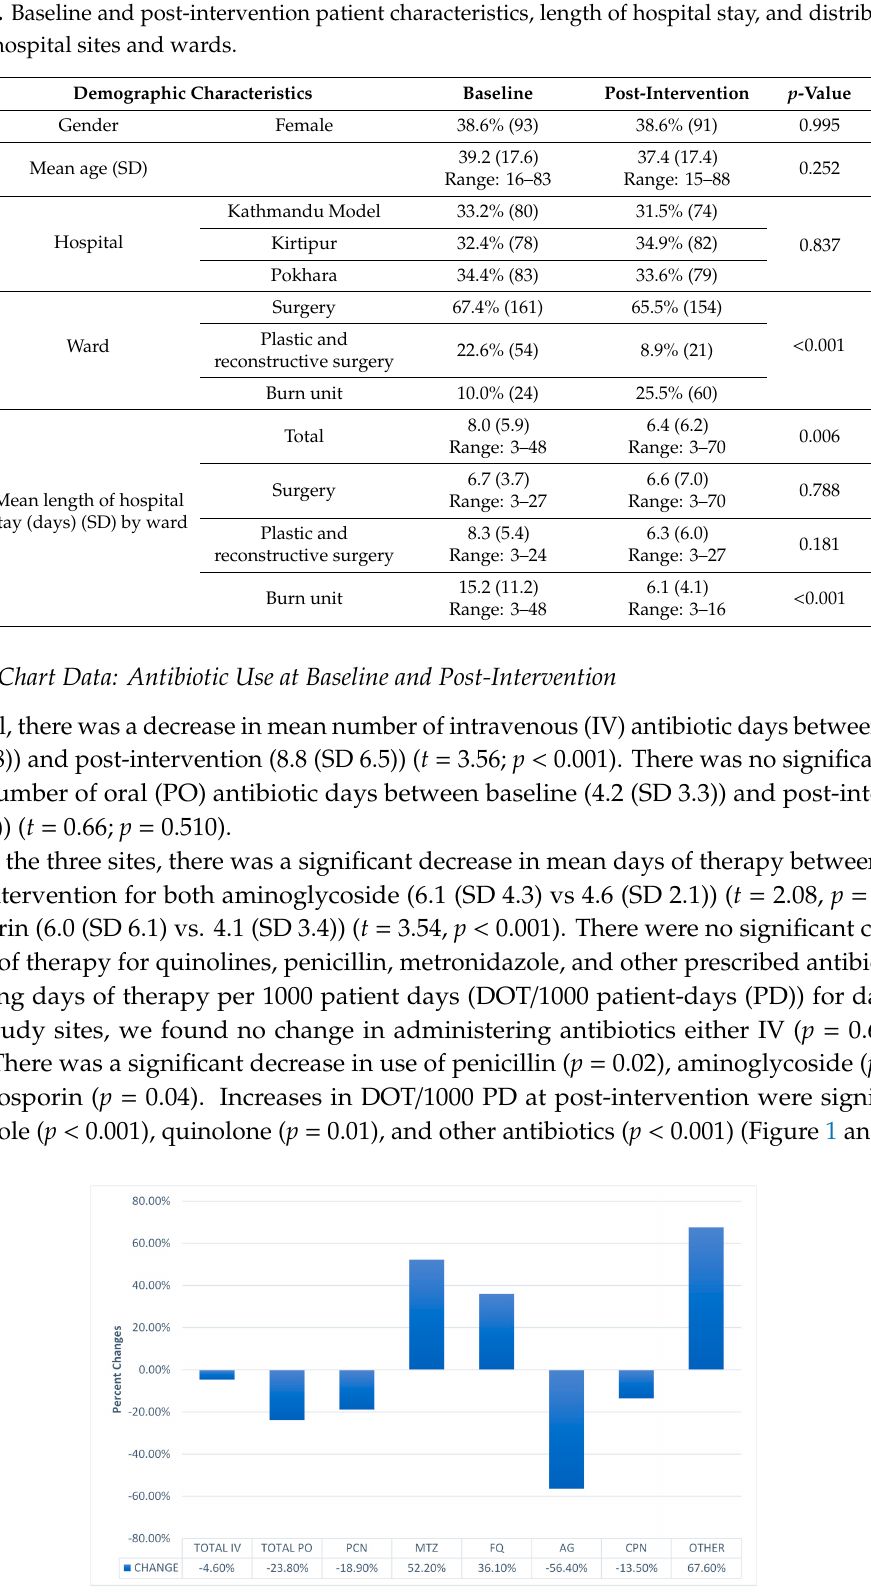
Figure 1. Changes in days of therapy (DOT) per 1000 patient-days (PD) between baseline and post-intervention in three hospitals in Nepal (Kirtipur, Kathmandu Model, and Pokhara hospitals). PCN = penicillin; MTZ = metronidazole; FQ: fluoroquinolone; AG: aminoglycosides; CPN: Table 2. Days of therapy (DOT) per 1000 patient-days (PD) of prescribed antibiotics at baseline and post-intervention periods total and by study sites (Kirtipur, Kathmandu Model, and Pokhara hospitals).